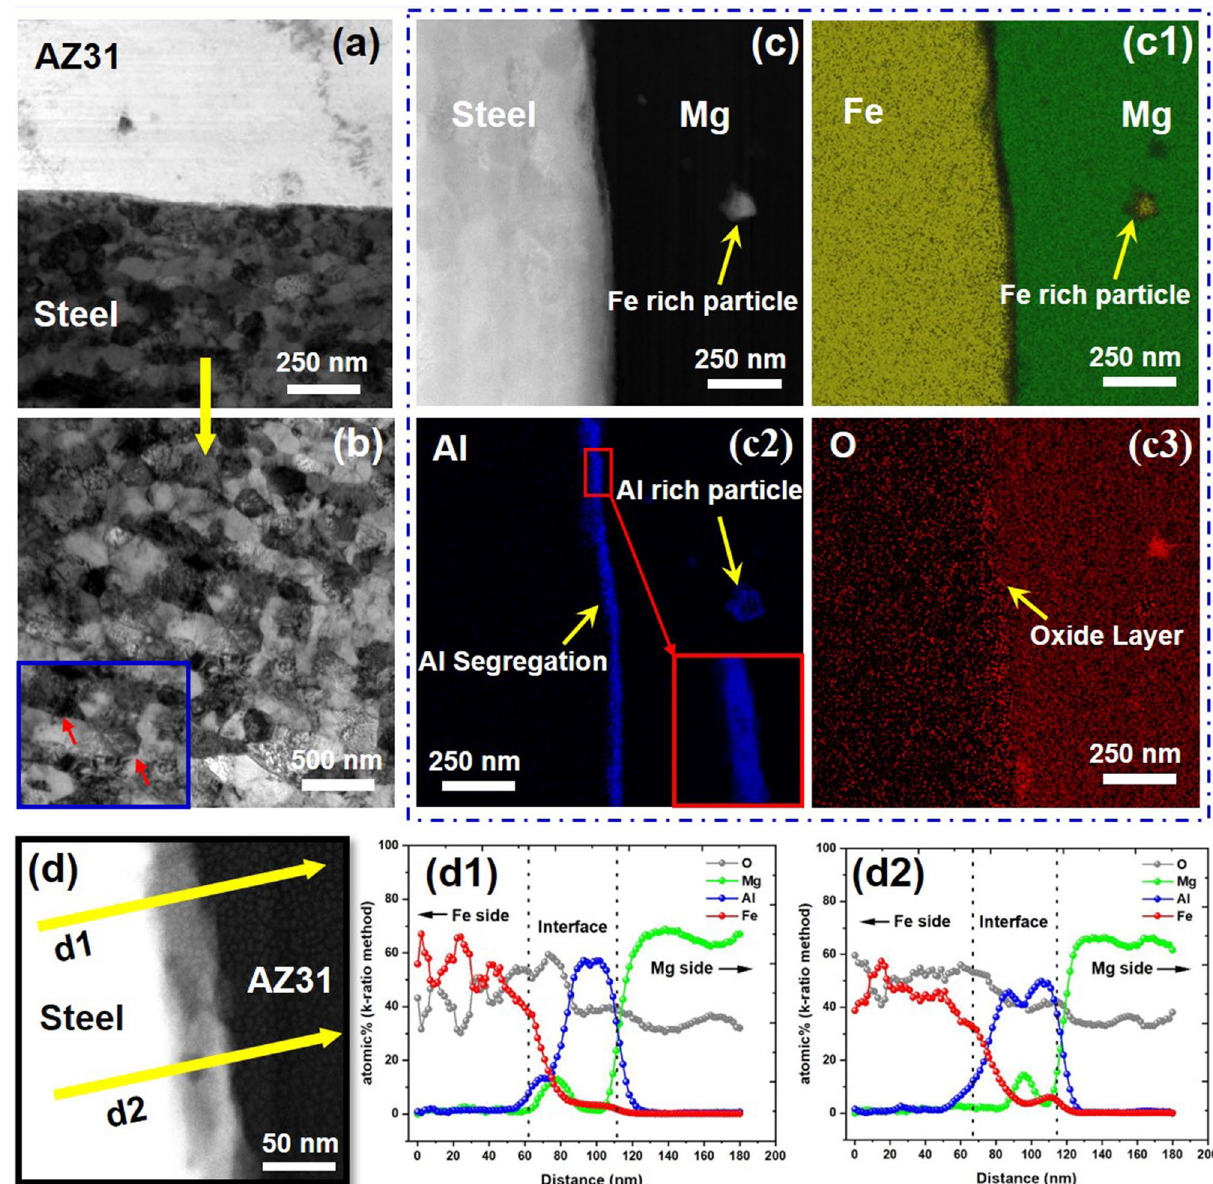
Figure 2. TEM with EDS of AZ31Mg-DP 590 joint. ( a ) Joint interface; ( b ) nano steel grains (inset: dislocations marked by red arrows); ( c ) S/TEM image, EDS mapping of (c1) Fe and Mg, (c2) Al (inset: high magnification view), (c3) O; ( d ) location of two EDS line scans; EDS line scan elemental analysis plots (d1) and (d2), for AZ31Mg-DP